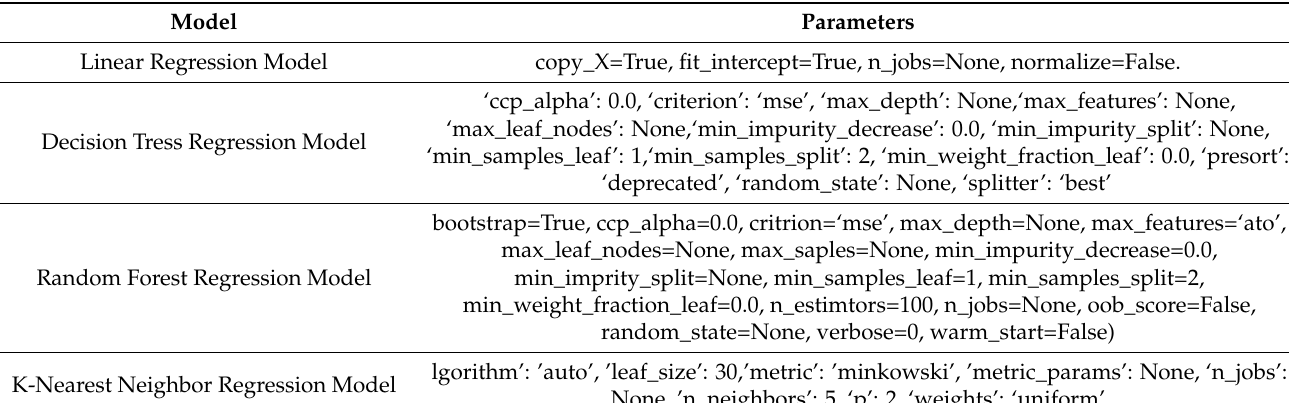
Table 3. Regression models’